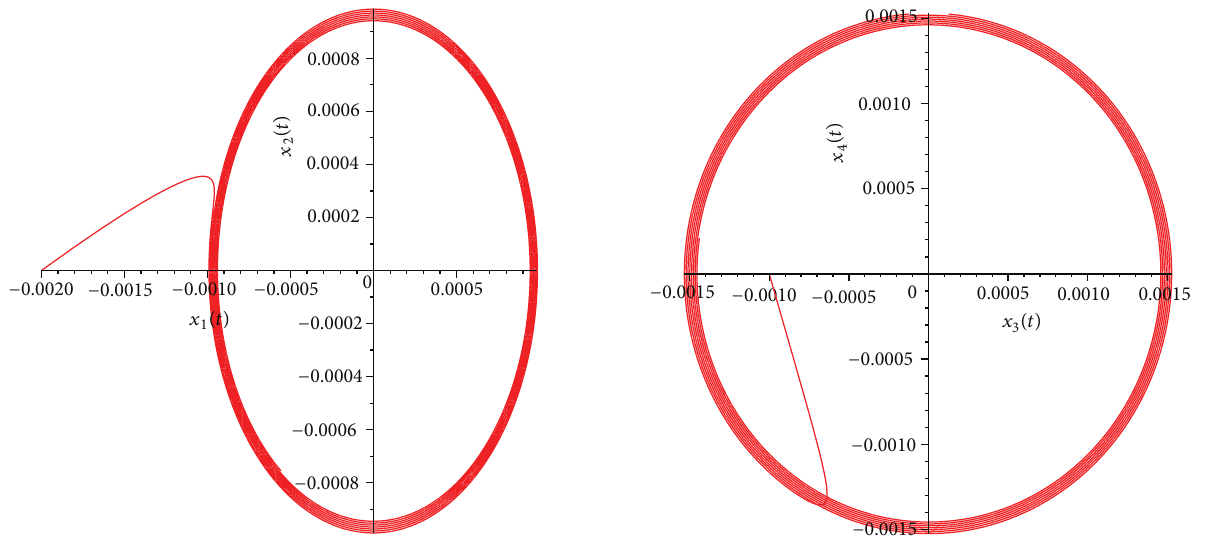
Figure 4: Trajectory projection starting from (𝑥 1 , 𝑥 2 , 𝑥 3 ,𝑥 4 ) = (−0.002, 0, −0.001, 0) converges to the E.S. when (𝜉 1 , 𝜉 2 ) = (−0.1, 0.08321) . (𝛿 , 𝛿 ) = (0.2, −0.3) , which is located in the area II 1 2